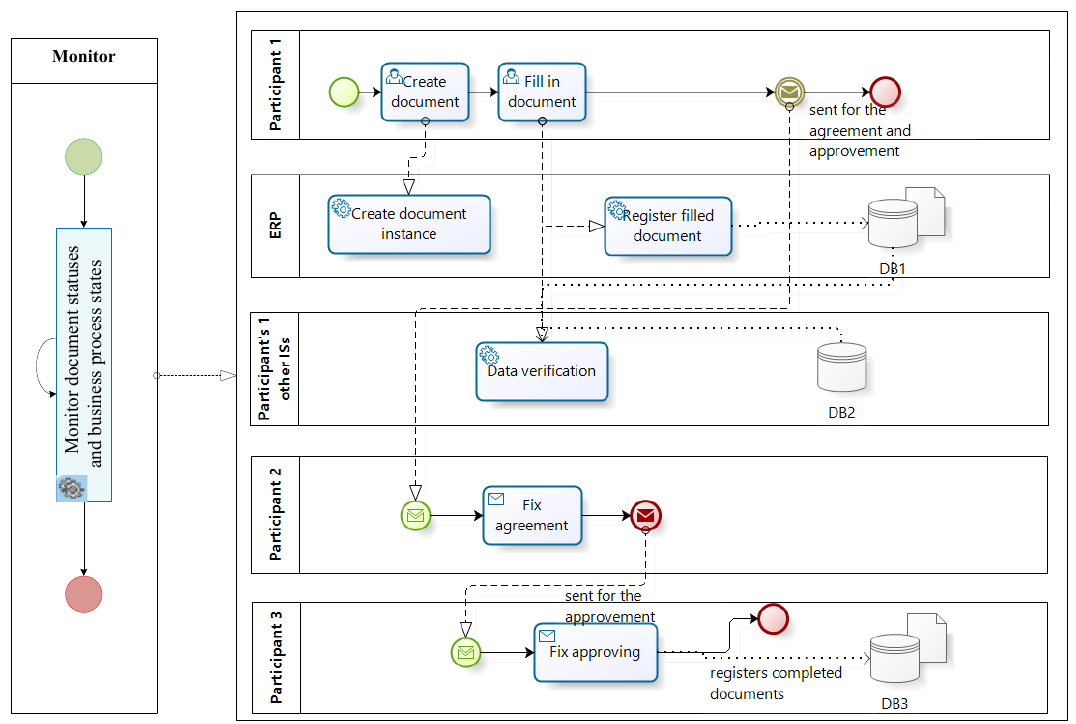
Figure 2. The simplified CBP from the ERP vendor’s